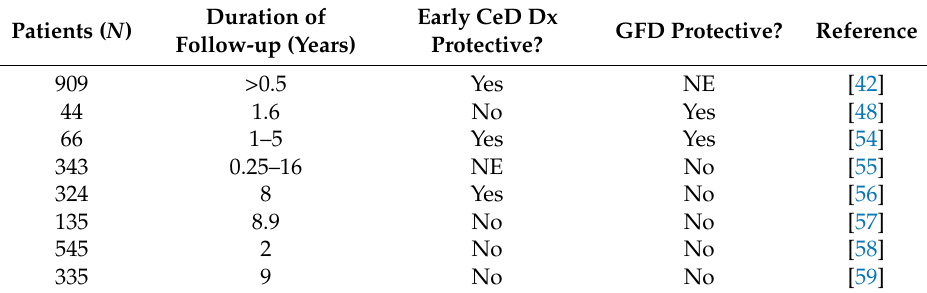
Table 4. Gluten exposure and occurrence of autoimmune thyroid disease